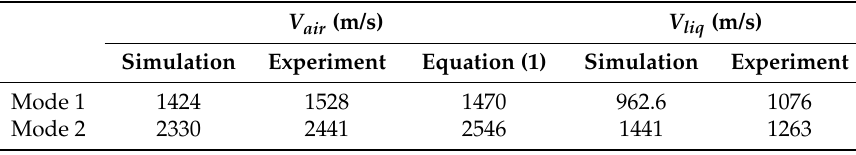
Table 1. Velocities of wedge wave in the air and the water.